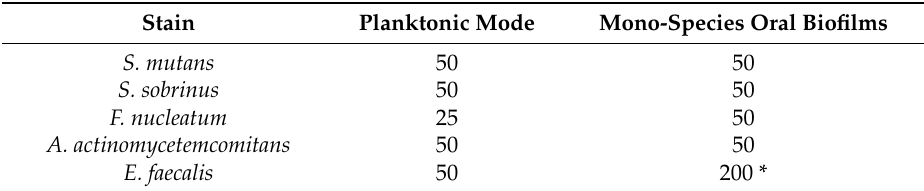
Table 2. The minimal inhibitory concentration (MIC, µ g/mL) of the mixed nanoparticles (Nano-MIX) of Nano-SB and nanoparticle-encapsulated chlorhexidine (Nano-CHX) at 9:1 ( w / w ) ratio against the planktonic mode and mono-species biofilms of selected oral bacteria at 24 h. Stain Planktonic